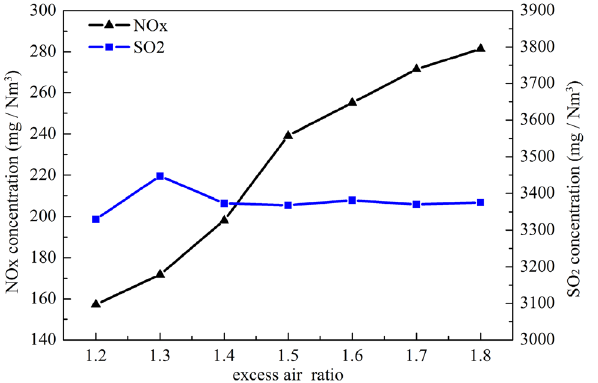
Fig. 9 Effect of excess air ratio on the NO and SO 2 emissions